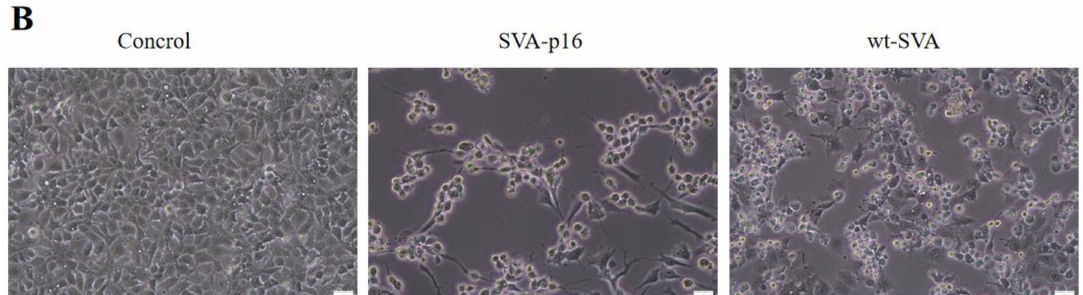
Figure 5. Oncolytic effects in Ishikawa cells. ( A ) Ishikawa cells were infected, respectively, with SVA-p16 and wild-type SVA as controls at the MOI of 0.01, 0.1, 1.0, and 10.0. Each bar represents the average of six independent parallels with standard deviation. Statistically significant differences with wild-type SVA are indicated (ns > 0.9999; **** p < 0.0001). ( B ) Ishikawa cells were infected, respectively, with wild-type SVA and SVA-p16 at the MOI of 1.0 after 24 h (10 × ). The ruler: 5 µ